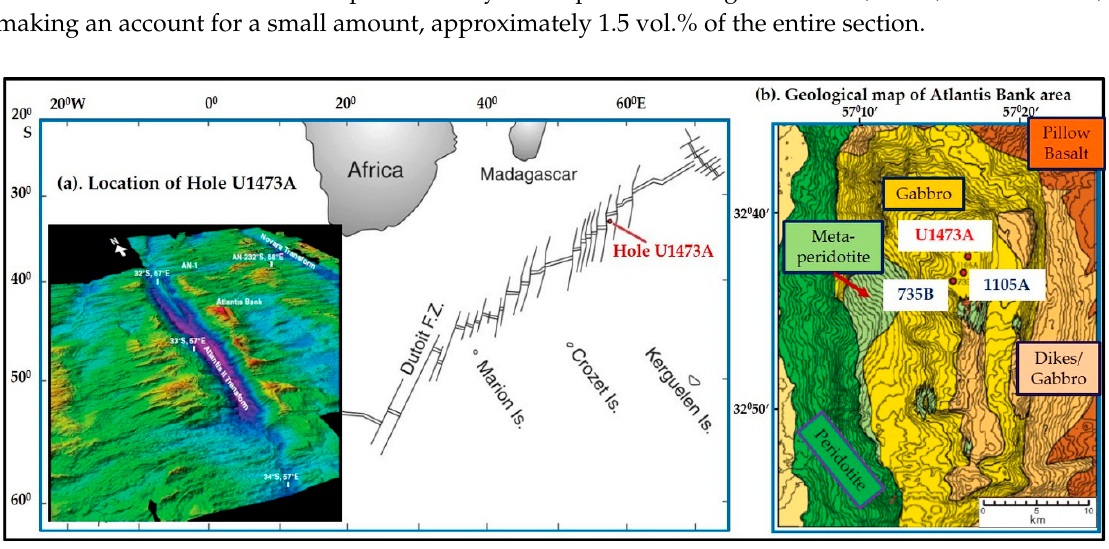
Figure 1. ( a ) Location of Hole U1473A and 3D view of the Atlantis Bank; ( b ) Summary of geological mapping with Ocean Drilling Program/International Ocean Discovery Program (ODP/IODP) drill sites marked and geological interpretation based on site survey results, modified from References [6,26].